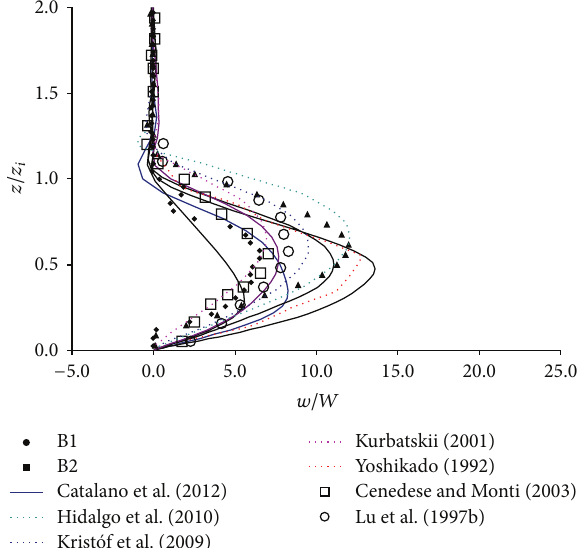
Figure36: Normalized vertical velocity component vertical profilesat 𝑥/𝐷 = 0 forthenumerical simulationsandthelaboratoryexperiments, compared with literature data: numerical results of Catalano et al. [92], Hidalgo et al. [93], Krist´of et al. [94], Kurbatskii [95], and Yoshikado [88]; laboratory experiments of Cenedese and Monti [97] and Lu et al.